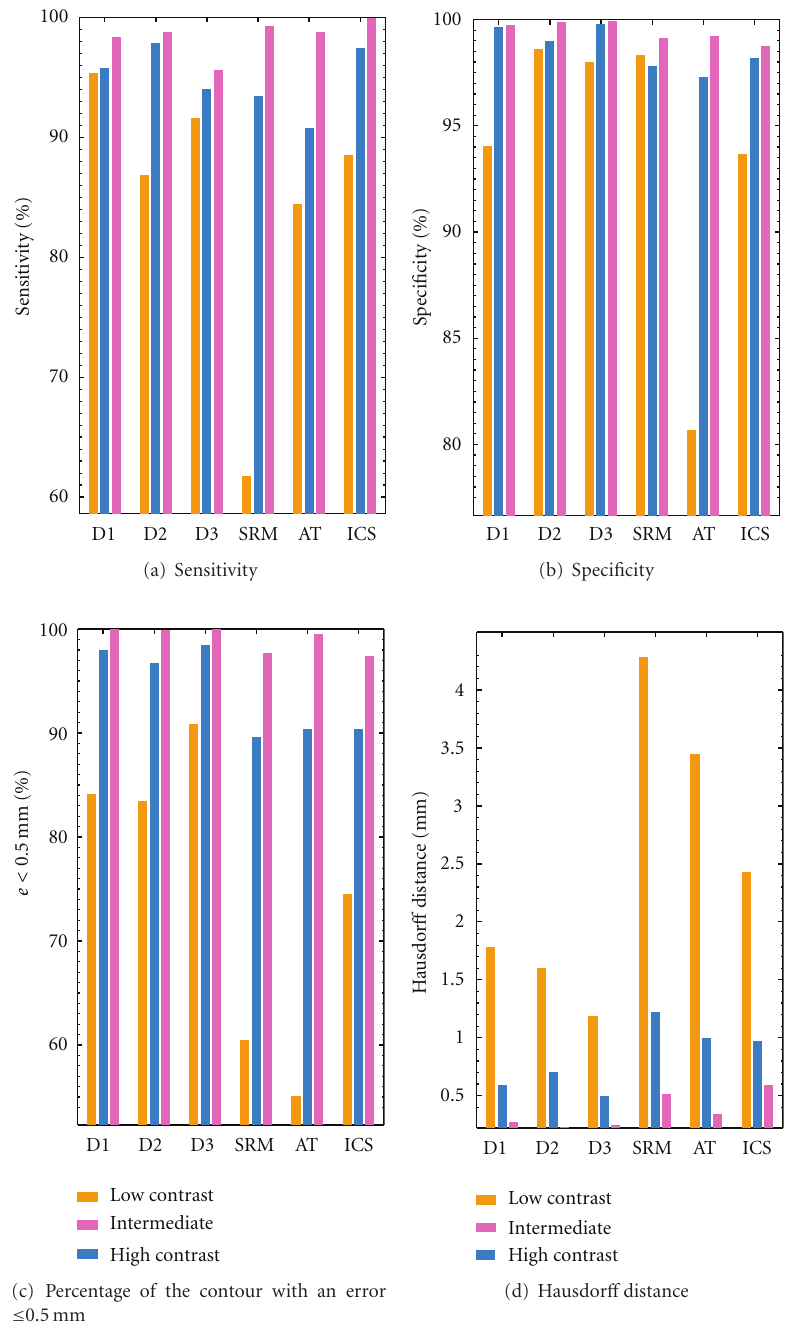
Figure 5: Average values of the accuracy of segmentation, quantified by the four distinct border measures, showing the performance of the proposed ICS method against the di ff erent segmentation methods analyzed. The lesions are grouped in three disjoint sets: low, intermediate, and high contrast between skin and lesion. The mask generate by majority voting of the manual segmentation by three dermatologists is used as ground-truth reference. The bars refer to low (orange), medium (blue), and high (pink) contrast lesions.